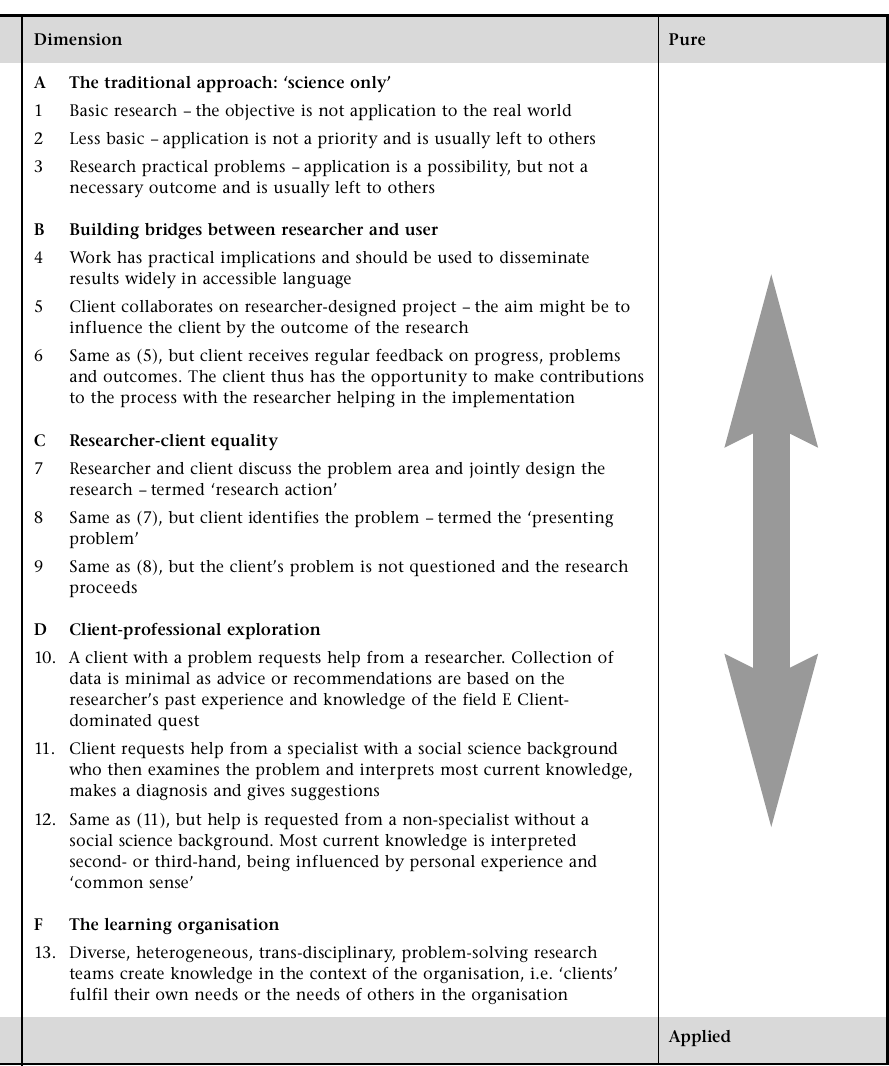
Figure 1 Approaches to solving research problems (Adapted from Robson,